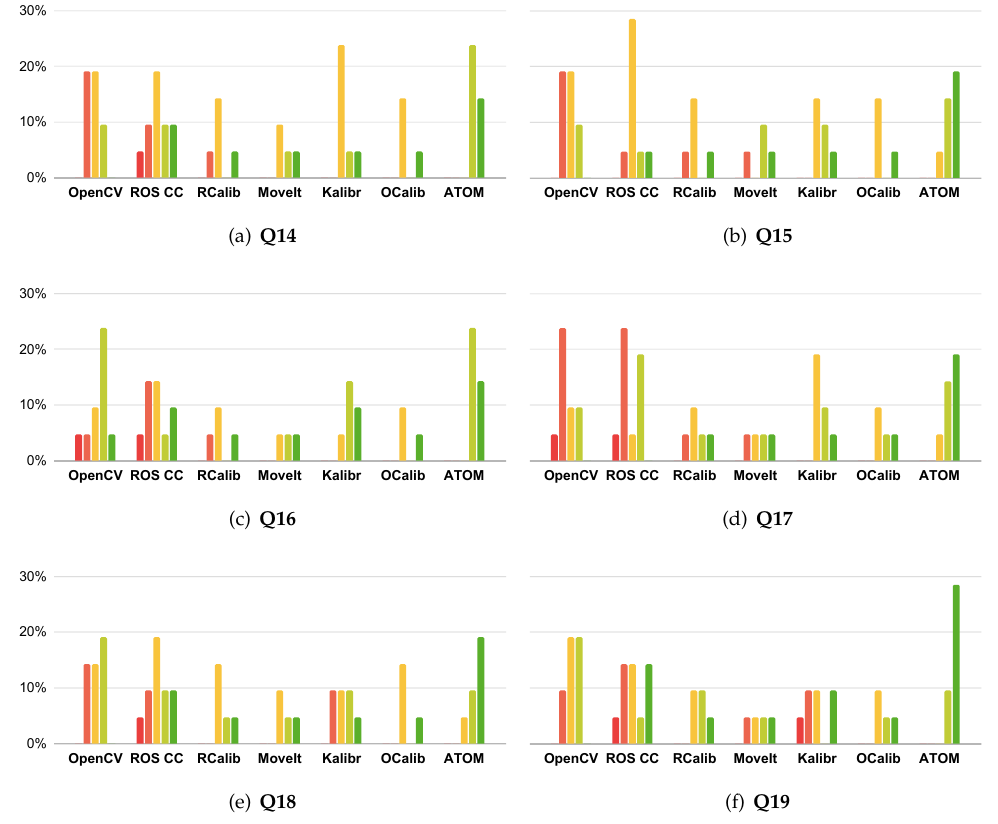
Figure 19. Responses to questions Q14–Q19 . Likert scale from 1 (strongly disagree) to 5 (strongly agree). Red represents 1, orange represents 2, yellow represents 3, light green represents 4 and green represents 5. Q14 —The collection of data for calibration is well solved by this approach. Q15 —The labeling of data for calibration is well solved by this approach. Q16 —The estimation of extrinsic parameters is well solved by this approach. Q17 —The evaluation of the result of the calibration is well solved by this approach. Q18 —The approach successfully calibrated my robotic system. Q19 —I am likely to use this approach